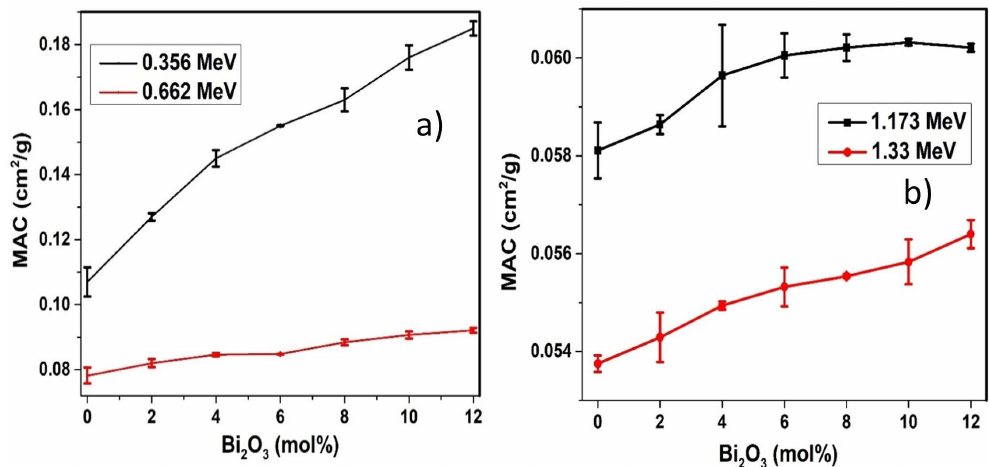
O concentration at 0.356, 0.662, 1.173 and 1.33 2 3